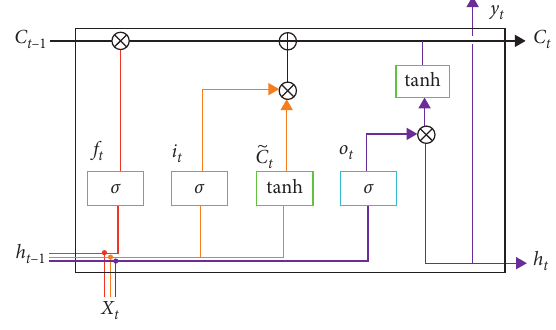
Figure 1: The basic unit structure of